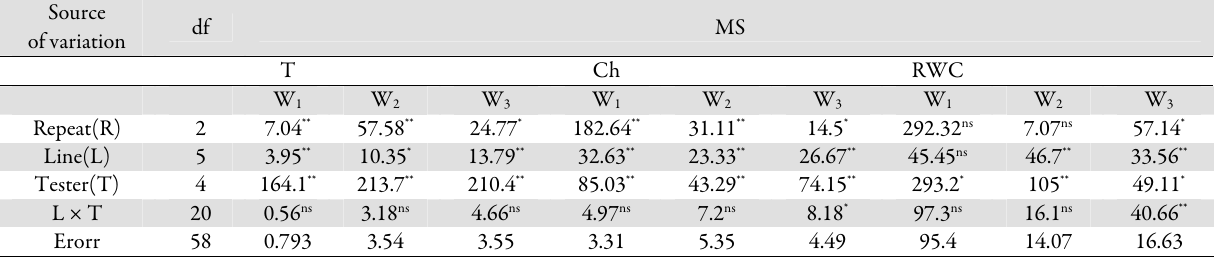
Tab. 2.1. Analysis of variance of line × tester in sunflower for canopy temperature (T), chlorophyll fluorescence (Fvm), chlorophyll content (Ch), relative water content (RWC)) at the different levels of irrigation